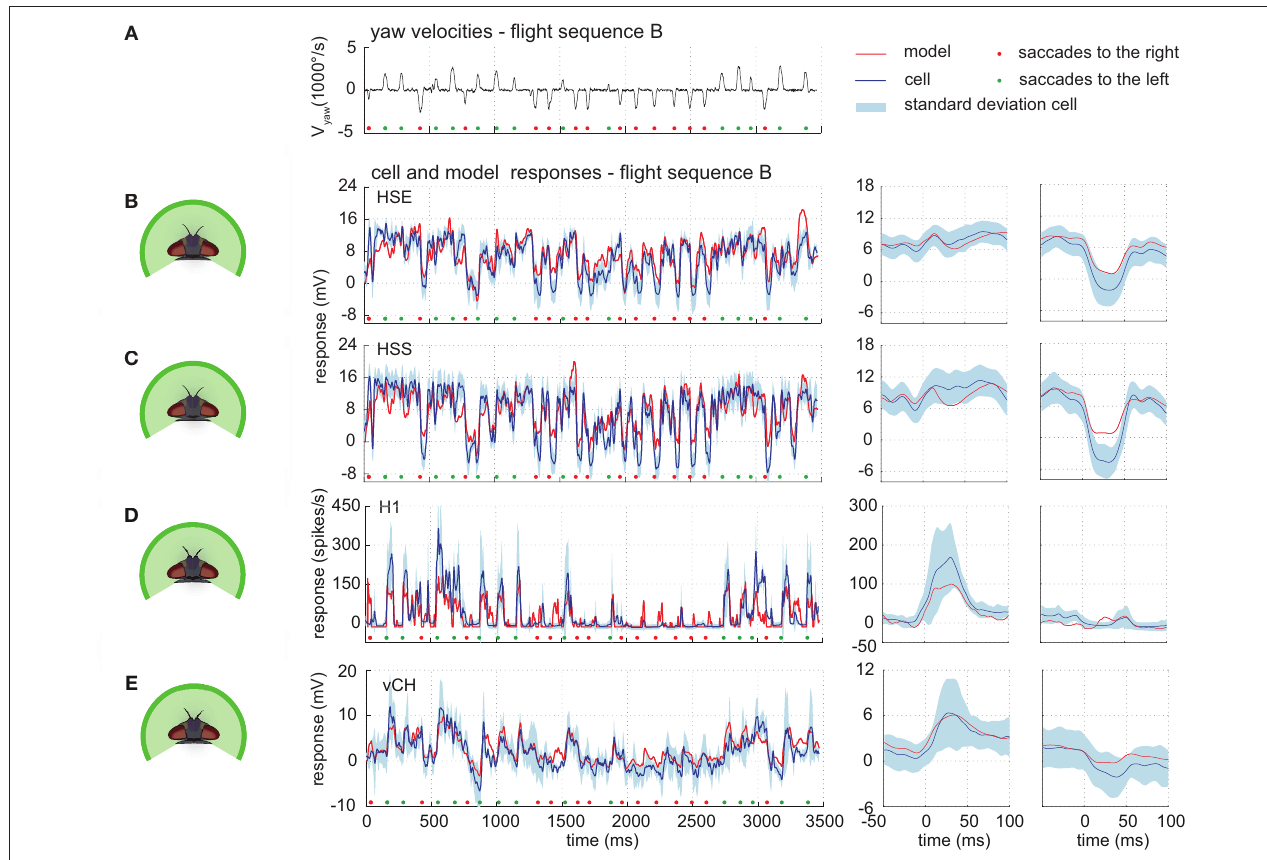
Figure 9 | responses to control flight. Electrophysiologically measured and modeled responses of the HSS-, HSE-, H1-, and vCH-cell to naturalistic motion stimulation. (A) Head yaw velocities plotted against time for flight sequence B. (B–e) Responses and STAs of cells (blue) and models (red) to flight sequence B to full stimulation. All color and sign codes as in Figure 4